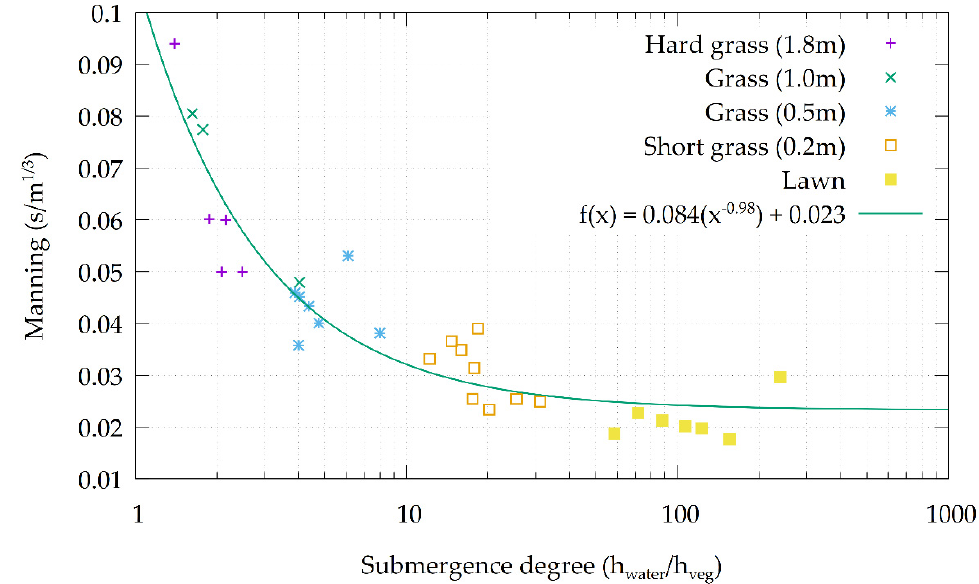
Figure 3. Relationship between the Manning roughness coefficient and the degree of submergence for different types of vegetation hardness and the regression curve.